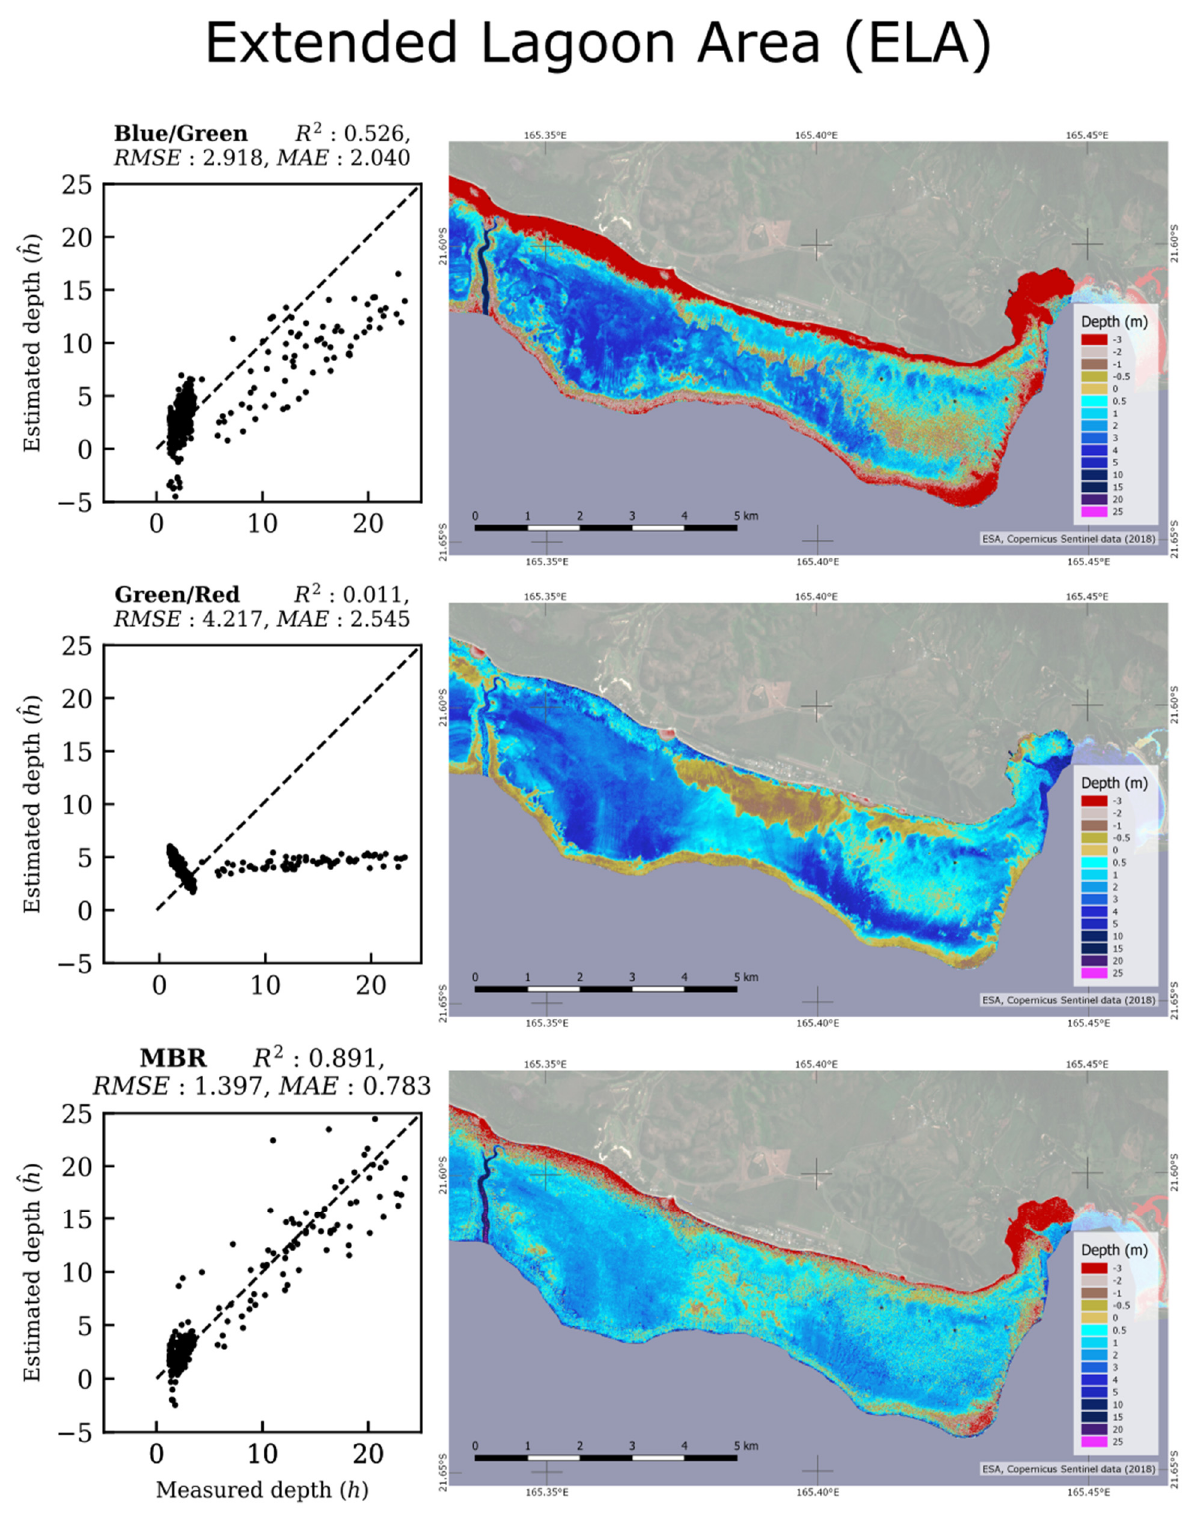
Figure 5. Applications to the ELA of the blue/green SBR model (top), the green-red SBR model (middle) and the MBR model (bottom). Predictions are at zero hydrographic level; therefore, red pixels are incoherent predictions, estimated above sea level. Accuracy metrics are provided above each validation plot on the left-inside.